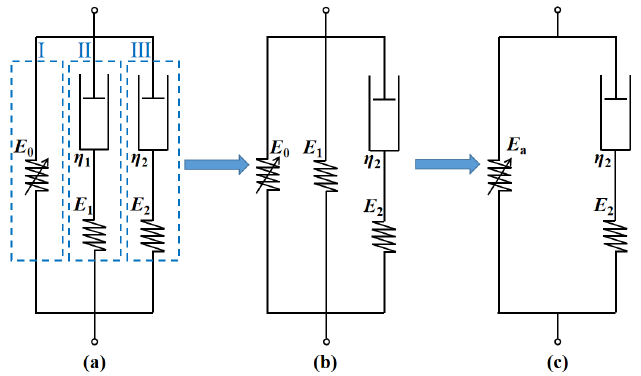
Figure 17. Schematic diagram of the modified ZWT model. Figure 17. Comparison of theoretical and test results. ( a ) impact pressure: 0.08 MPa; ( b ) impact pressure: 0.10 MPa; ( c ) impact pressure: 0.12